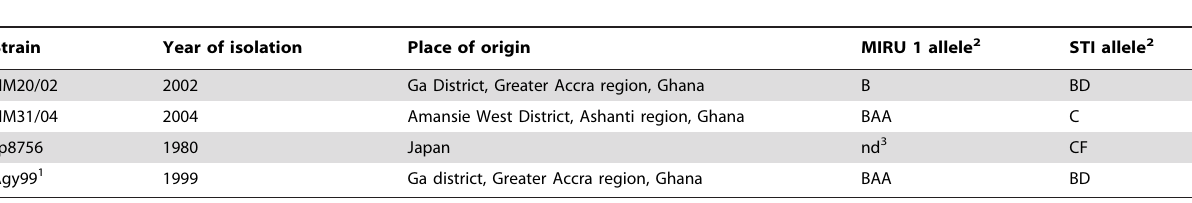
Table 1. Mycobacterium ulcerans strains sequenced in this